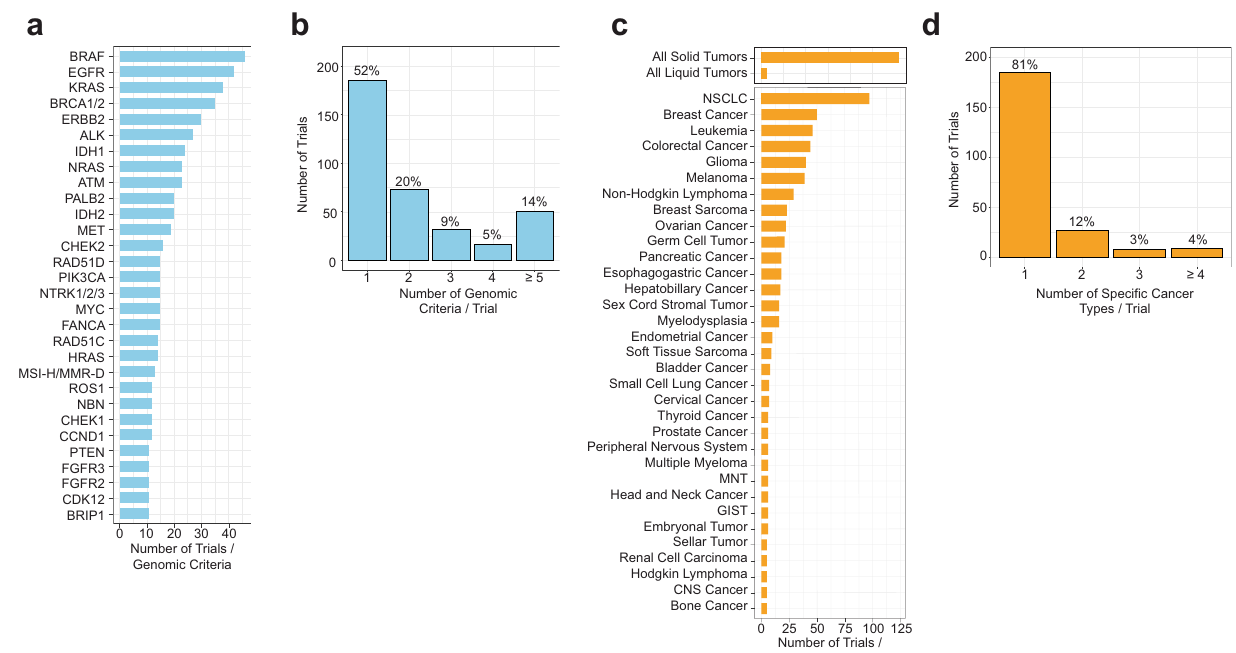
Fig. 3 The landscape of genes and cancer types in DFCI precision medicine trials. a , b Number of trials in MatchMiner for select genomic criteria ( ≥ 10 trials) and number of trials that have 1, 2, 3, 4, and ≥ 5 genomic criteria. c , d Number of trials in MatchMiner for select cancer types (>4 trials) and number of trials that have 1, 2, 3, and ≥ 4 speci fi c cancer types. NSCLC non-small cell lung cancer, GIST gastrointestinal stromal tumor. MNT Miscellaneous Neuroepithelial Tumor. Trials with eligibility for all solid or all liquid tumors were not included in ( d